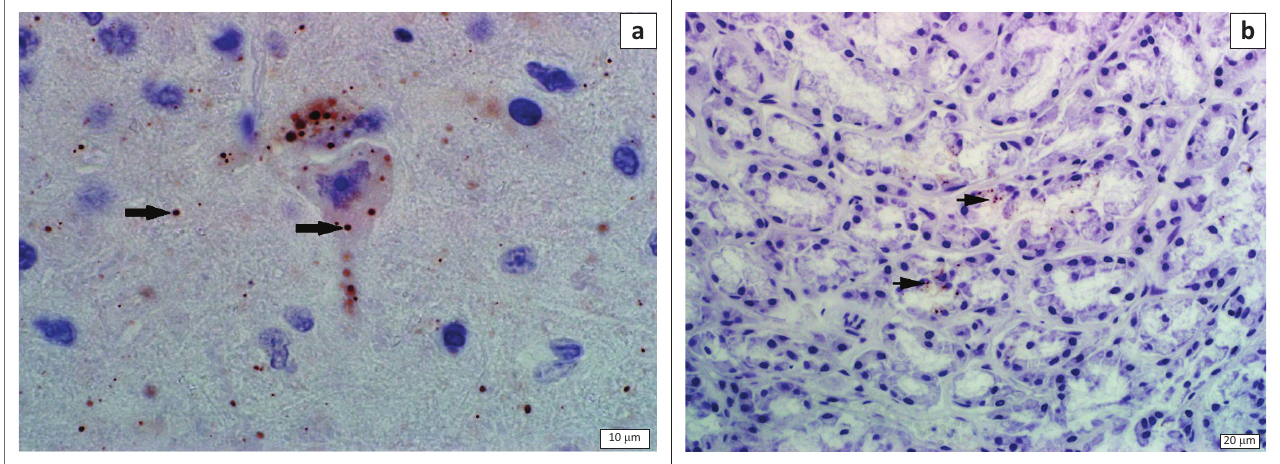
FIGURE 3: (a) Wild dog hippocampus; rabies antibody immunohistochemical labelling with haematoxylin counterstain (1000× magnification). Viral inclusion bodies, Negri bodies, present within hippocampal neurons and small viral inclusions (rabies dust) present within the neuropil (arrows). (b) Wild dog (case 889/14) mandibular salivary gland, immunohistochemical rabies antibody labelling with haematoxylin counterstain (400× magnification). Numerous small red-brown viral inclusion bodies (arrows) within salivary gland epithelium. This corroborates the known route of transmission via saliva and indicates the advanced stage of infection with rabies